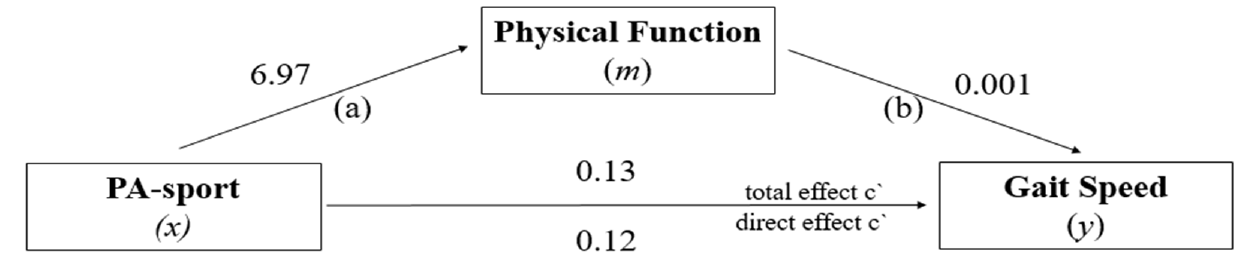
Figure 5. PF model as a mediator of the effect of PA-sport on GS.